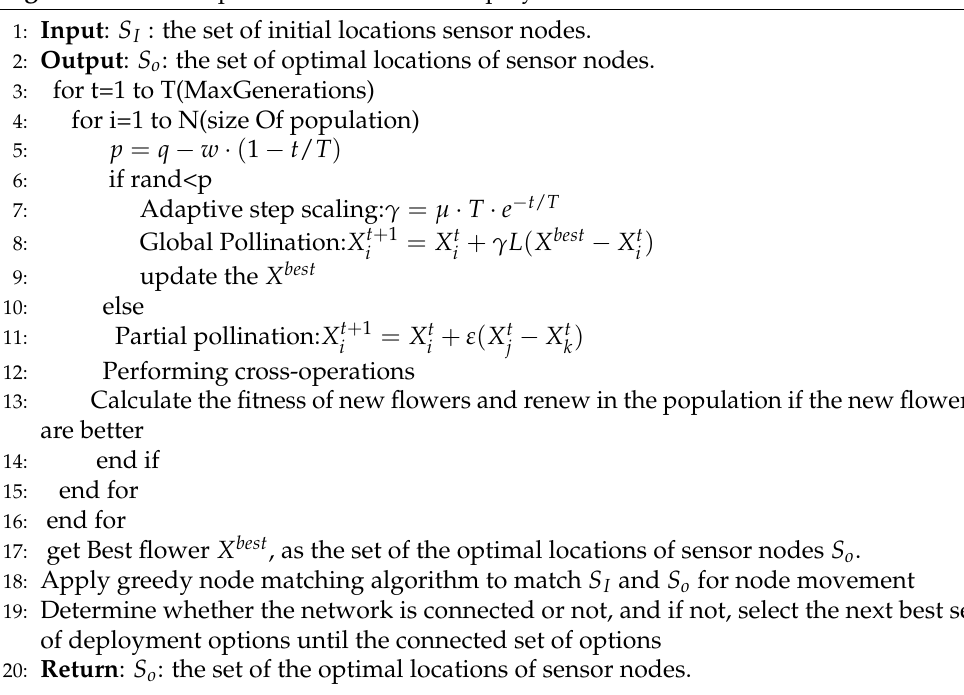
Figure 3. Flow chart of the coverage optimization algorithm. Algorithm 1 The improved FPA for WSN